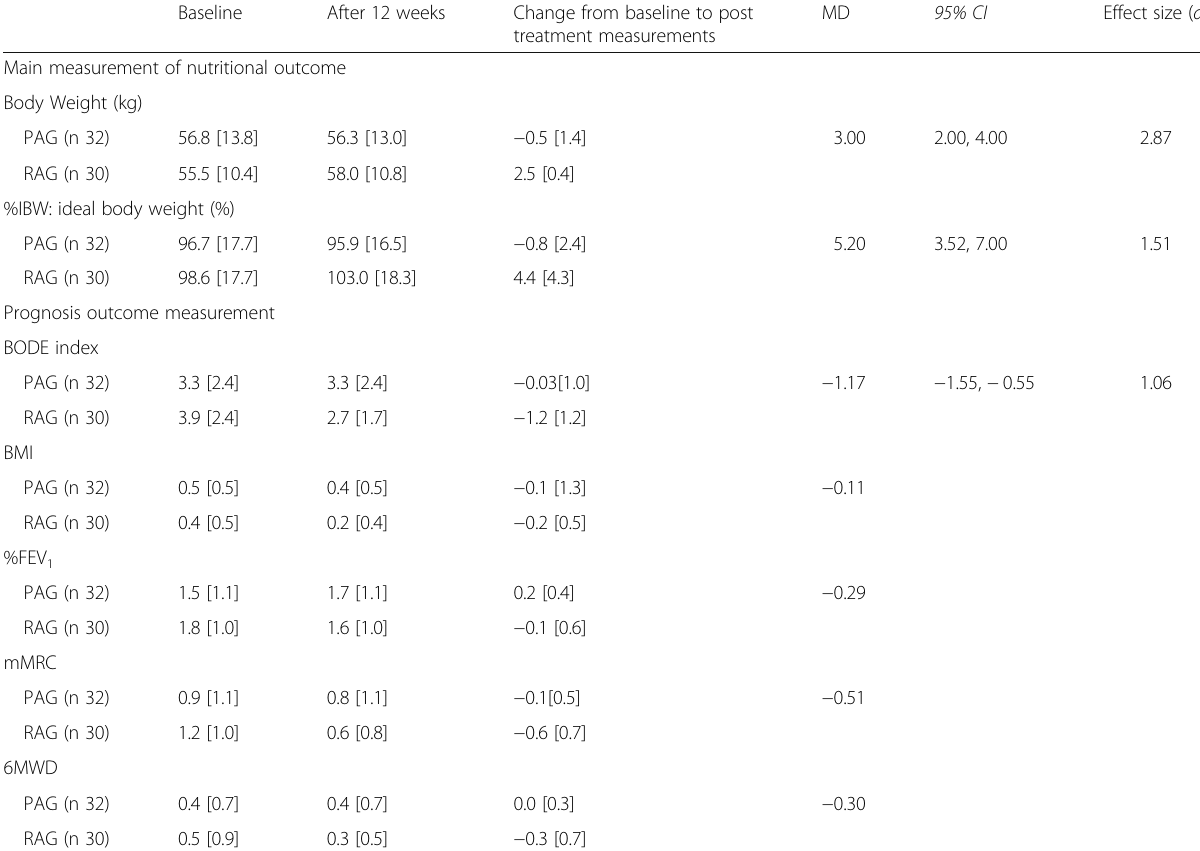
Table 2 Changes in the nutritional outcome and prognosis Baseline